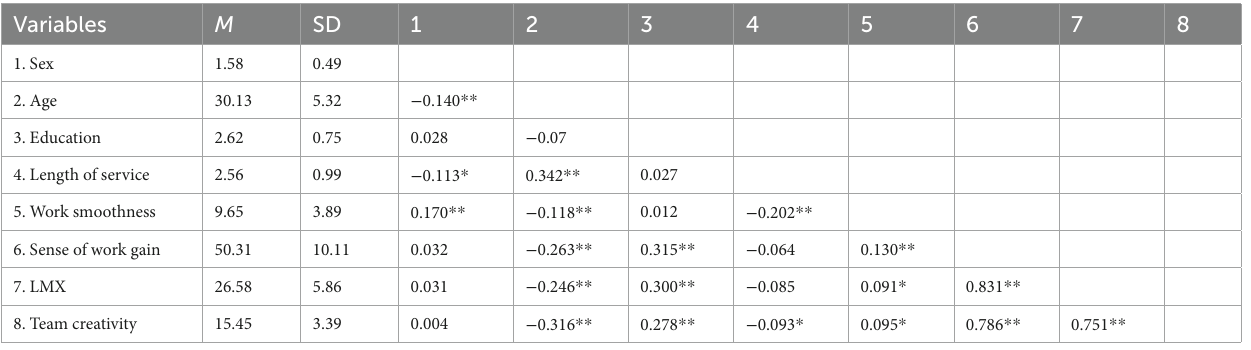
TABLE 2 Means, SD, and correlations of the